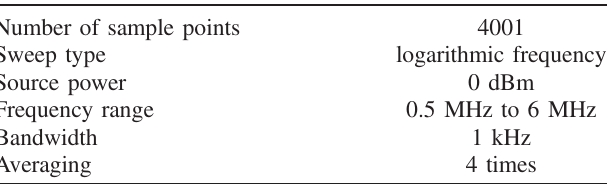
TABLE I. Common settings of the network analyzer for both measurement methods.